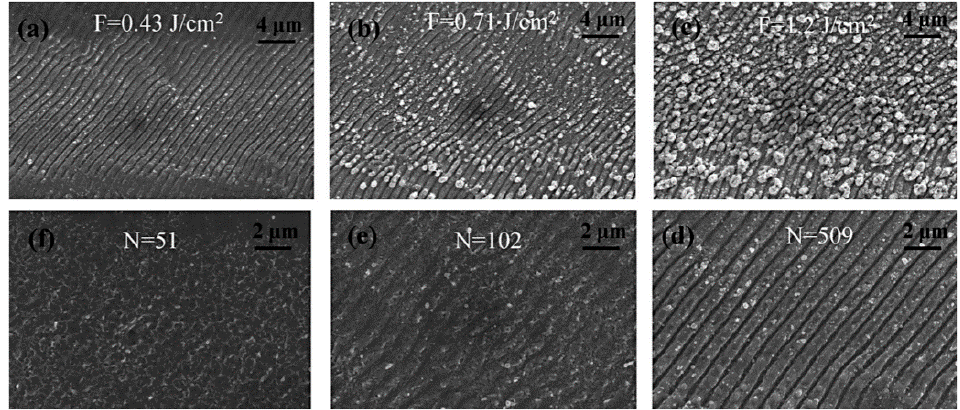
Figure 4. LIPSS fabricated on copper surfaces with ( a – c ) different laser fluences F at fixed pulse number N = 509 and ( d – f ) with different number of pulses N at F = 0.43 J/cm 2 . Reprinted from Long et al . [49], Copyright 2014, with permission from Elsevier.